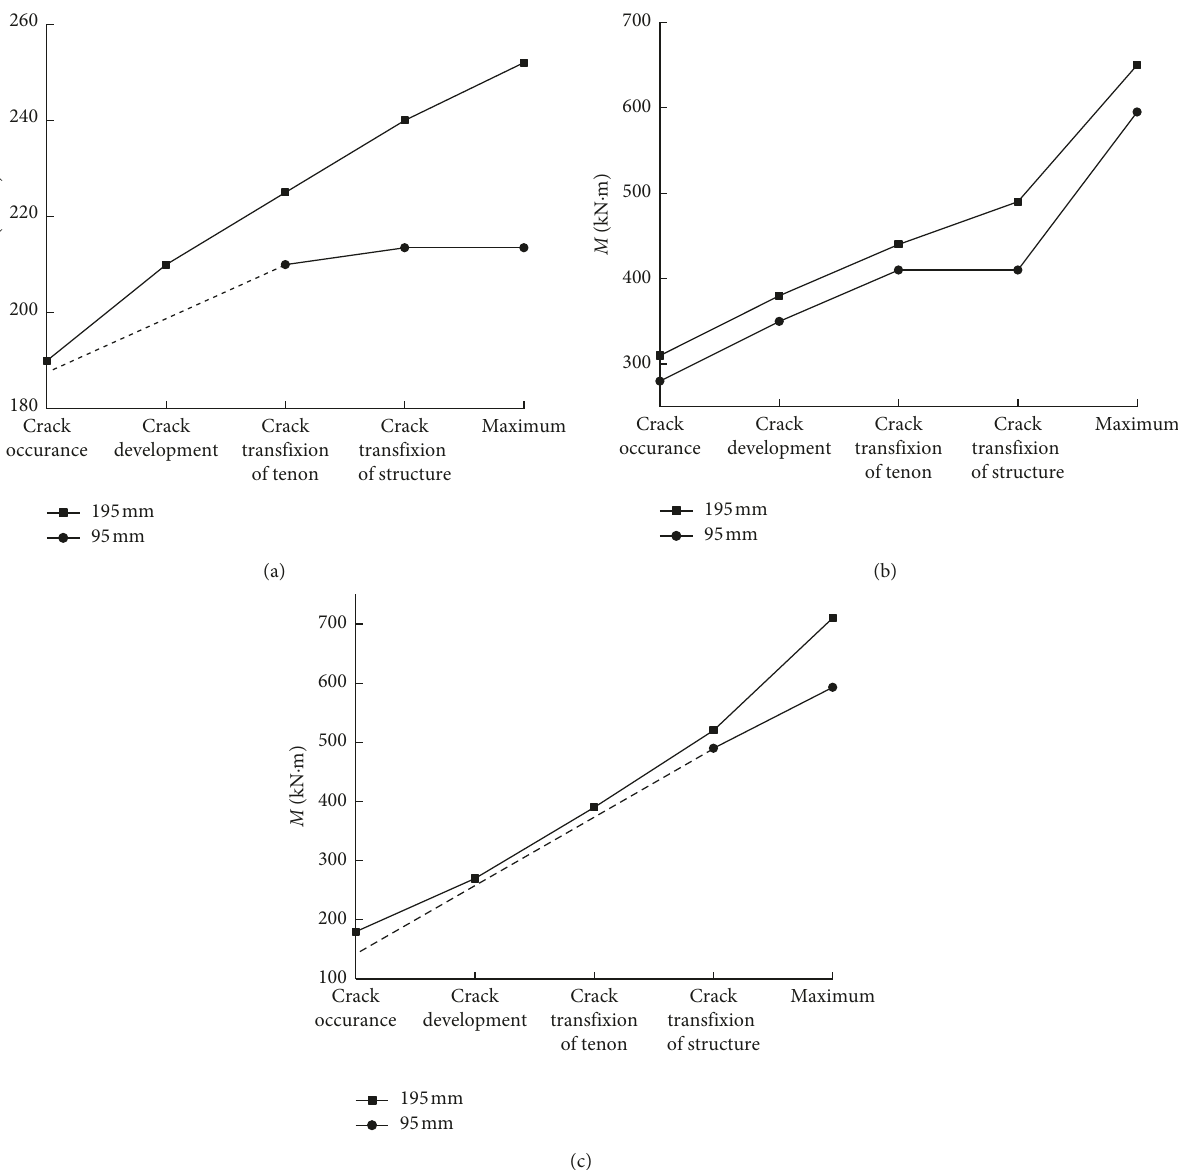
Figure 17: Key bending moments of joints with different tenon lengths and (a) modified epoxy resin grout at 500kN axial load, (b) modified epoxy resin grout at 1600kN axial load, and (c) modified cement-based material at 1600kN axial